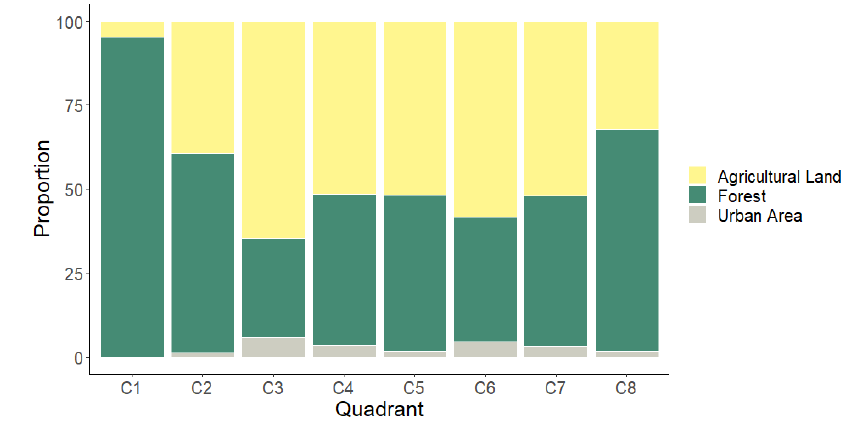
Figure 4. Proportion of vegetation cover by quadrant.